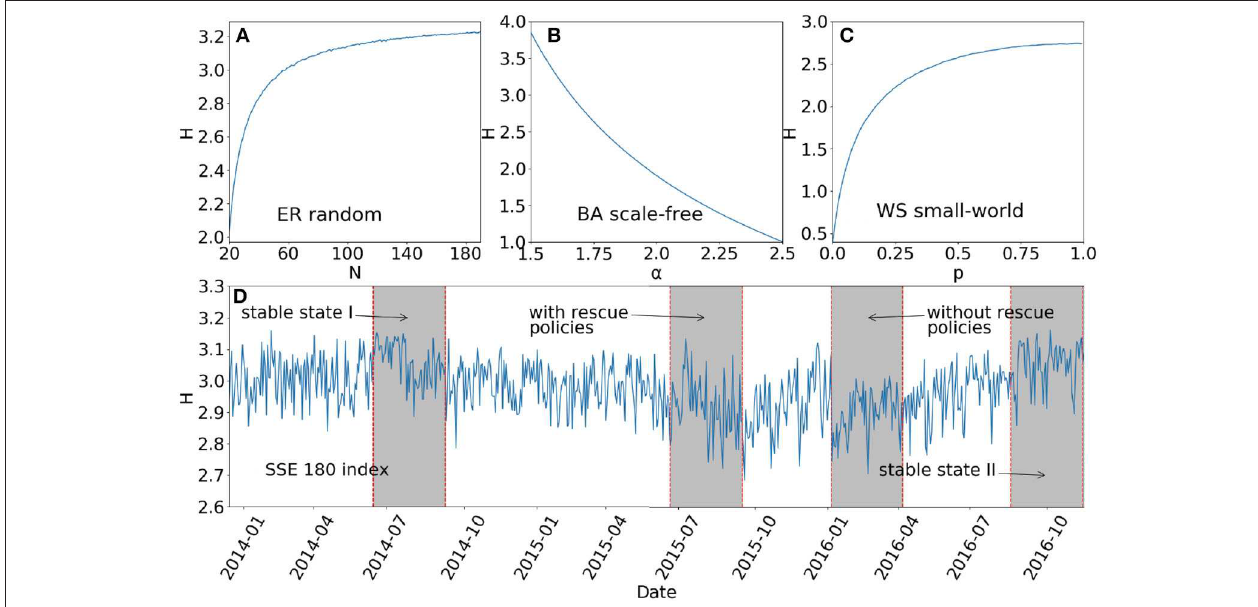
FIGURE 1 | Entropy of (A) the ER random network with Np = 6 for various N ; (B) the BA scale-free network for N = 180, m = 1 and various α ; (C) the WS small-world network for K = 6, N = 180 and various p ; and (D) the stock network for the sampling period from 16 December 2013 to 22 November 2016 in the Shanghai stock market.